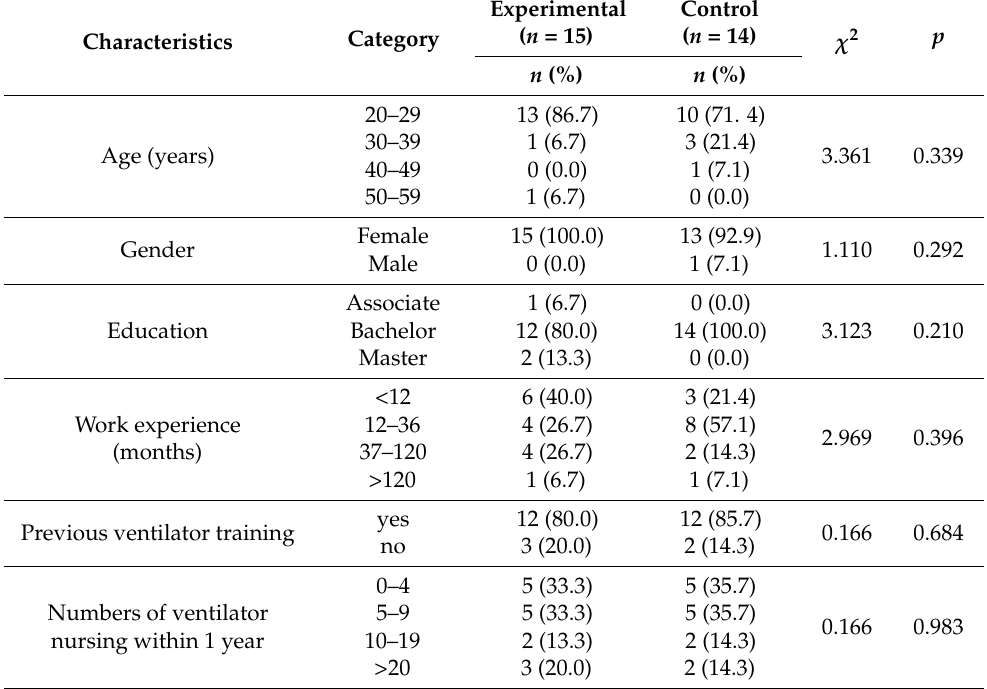
Table 1. Participants’ general characteristics.